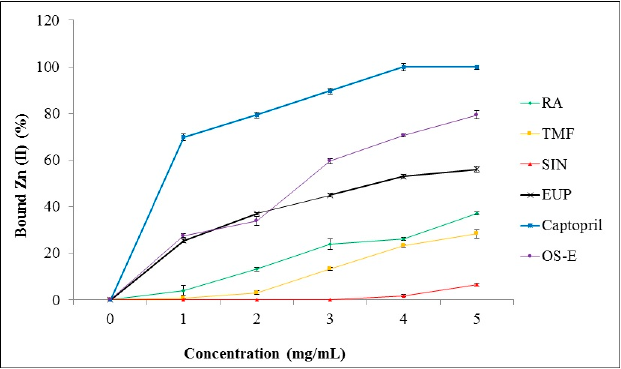
Figure 5. Zn (II) chelating activity of OS-E, RA, TMF, SIN, EUP and captopril. Data are presented as mean ± SD.